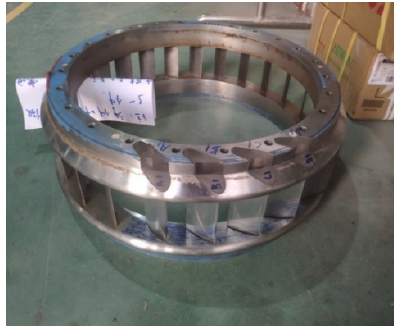
Figure 2. Transparent vane.